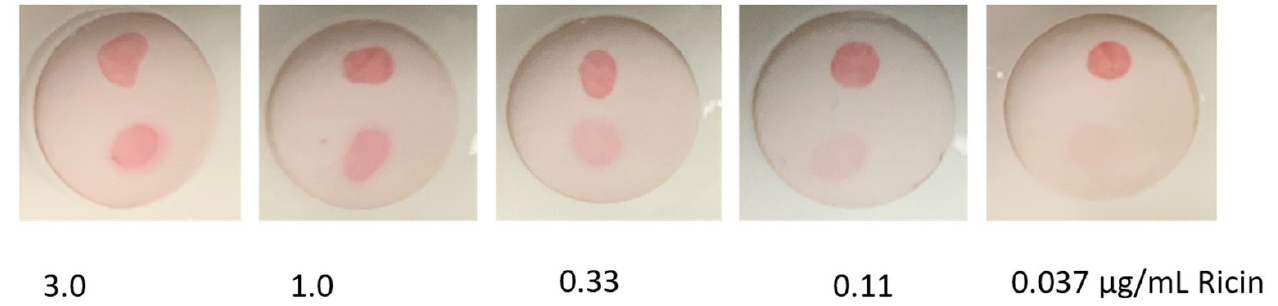
Figure 3. Vertical flow assay for the detection of Ricin using D12f-RZ coated AuNPs. Each Miriad test cartridge was spotted with F6H2Y anti-ricin sdAb near the bottom and goat anti-VHH near the top, as a control. After each cartridge was challenged with 100 µL of ricin at the indicated concentration, 100 µL of D12f-RZ-Bt-sheep-IgG-AuNP was applied to generate the colored spot.